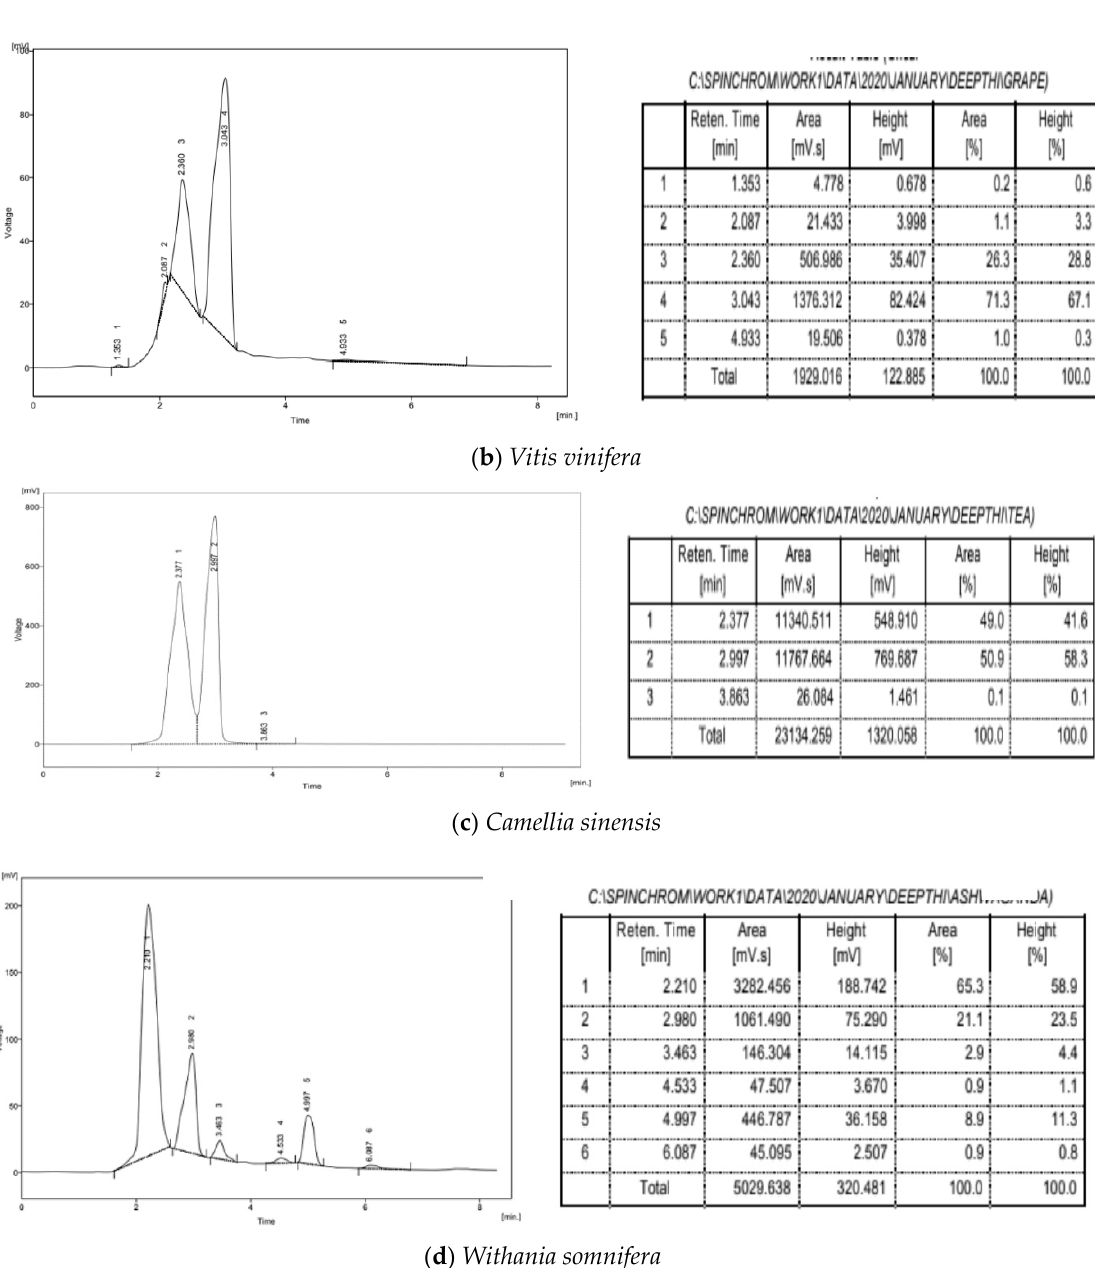
Figure 5. ( a ) HPLC report of gallic acid. ( b ) HPLC report of gallic acid. ( c ) HPLC report of Camelia sinensis . ( d ) HPLC report of Withania somnifera.